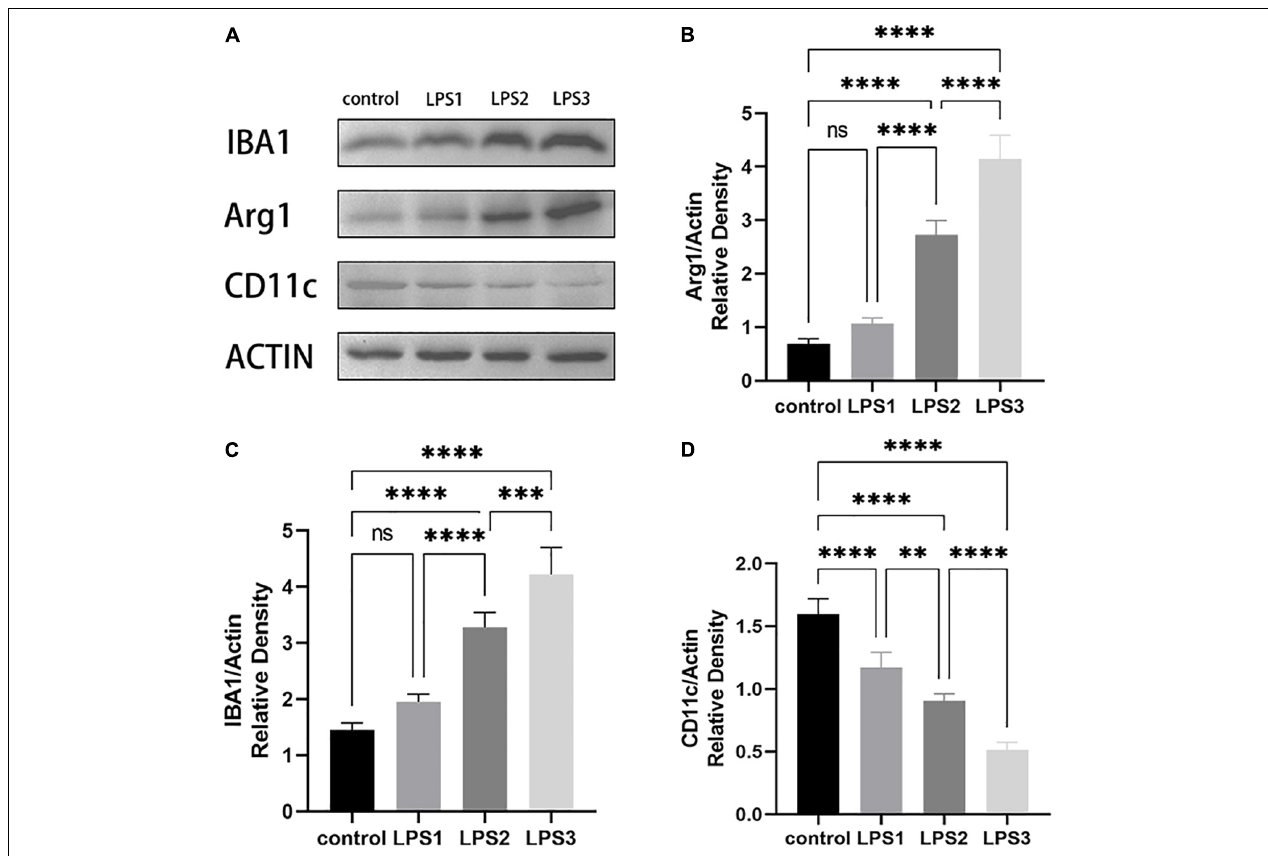
FIGURE 7 | Western Blot of Arg1, CD11c, and IBA1 ( n = 2–3 brains per group). (A) WB bands of the control group, low dose, medium dose, and high dose WMI + LPS groups. (B–D) The histograms represent the normalized relative density of Arg1(B), CD11c(C), and IBA1(D) between the control group and experimental groups. Data are presented as the mean ± SE. Compared the mean of each group with the mean of every other group by the Bonferroni test. ns > 0.05, ∗∗ P < 0.01, ∗∗∗ P < 0.001, ∗∗∗∗ P <